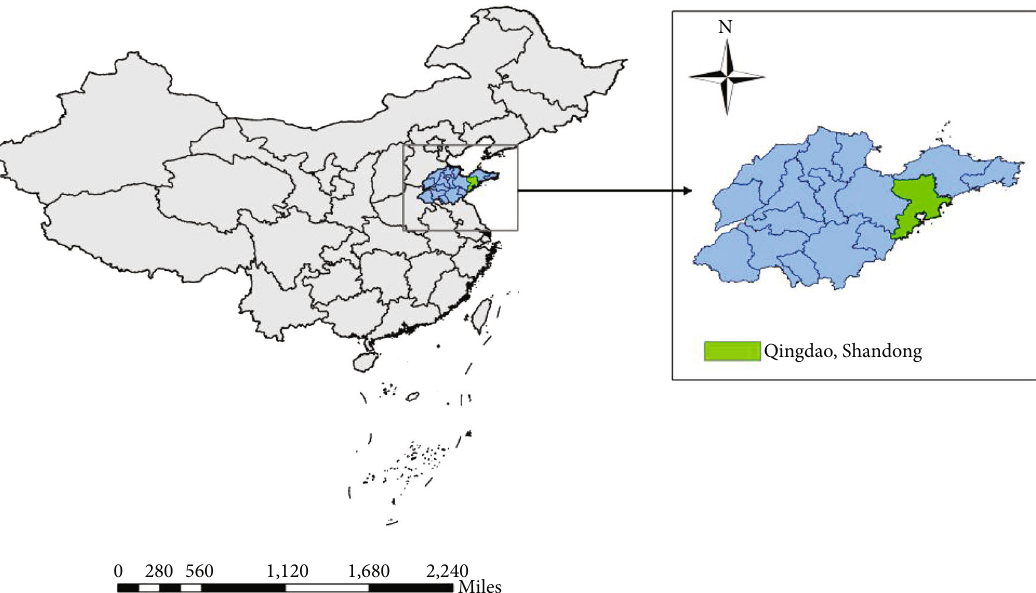
Figure 4: Map of Qingdao city, Shandong Province, China.